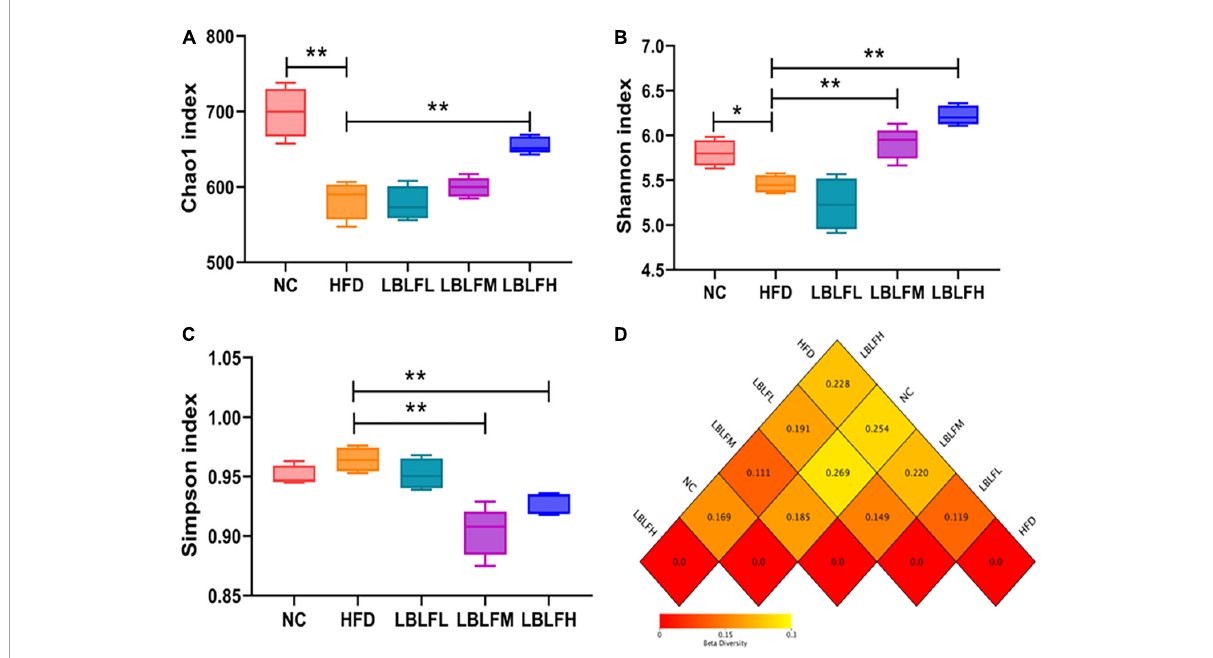
FIGURE6 Effects of LBLF supplement on gut microbial α -diversity and β -diversity in obese mice. (A) Chao1 index, (B) Shannon index, and (C) Simpson index as the estimators of α -diversity of gut microbiota. Increased α -diversity with the increase of Chao1 index and Shannon index as well as the reduction of Simpson index. (D) Distance matrix heatmap as the estimators of β -diversity of gut microbes showed the extent of the similarities of the intestinal microbial compositions. A smaller difference coefficient means a bigger extent of the similarity (* p < 0.05) and (** p < 0.01) vs. HFD